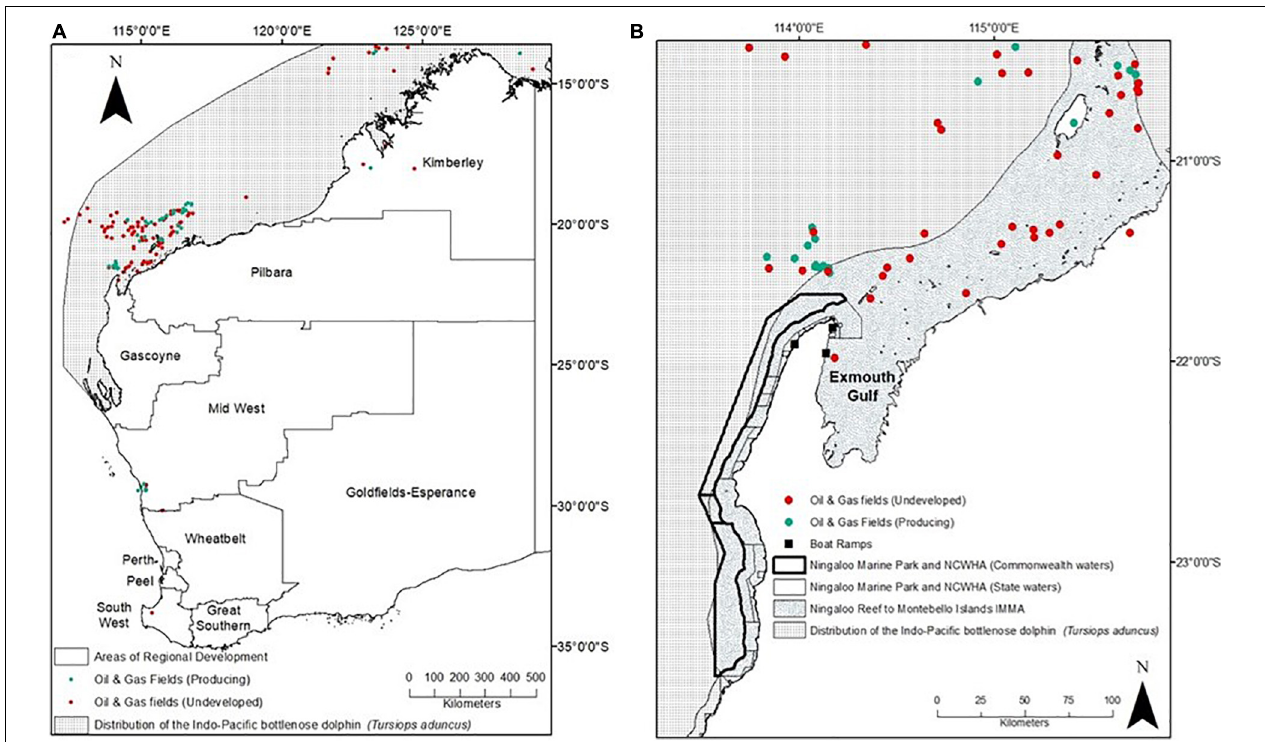
FIGURE 1 | (A) Map of Western Australia showing the inferred distribution of Indo-Pacific bottlenose dolphins, the location of producing and undeveloped oil and gas fields, the boundaries of Western Australia’s areas of regional development and the location of North West Cape (in box). (B) Map of the North West Cape showing the distribution of Indo-Pacific bottlenose dolphins, boat ramp locations, oil and gas fields, the boundaries of the State and Commonwealth Ningaloo Marine Parks and the marine component of the Ningaloo Coast World Heritage Area (NSWHA) and the Ningaloo Reef to the Montebello Islands Important Marine Mammal Area (IMMA) (IUCN-MMPATF,